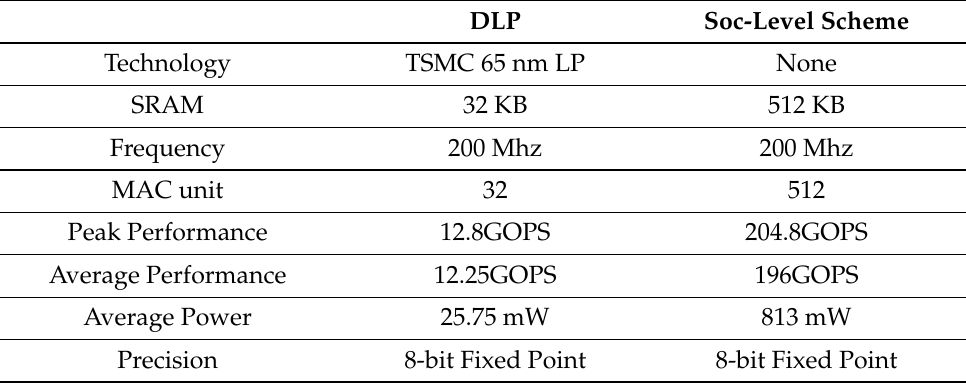
Table 7. The characteristics of DLP and Soc-level